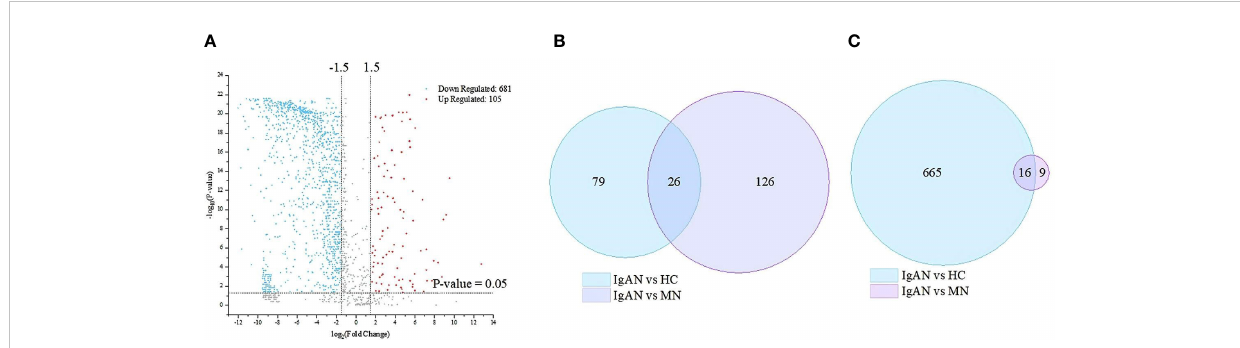
FIGURE 1 Based on mass spectrometry analysis of the discovery cohort, there are 786 and 177 differentially expressed proteins between IgA nephropathy (IgAN) and healthy controls (HC) and between IgAN and membranous nephropathy (MN), respectively. (A) Volcano plot of the differentially expressed proteins in the IgAN and HC. (B) Venn diagram of the up-regulated differential proteins in the IgAN vs. HC, and IgAN vs MN respectively. (C) Venn diagram of the down-regulated differential proteins in the IgAN vs HC, and IgAN vs MN